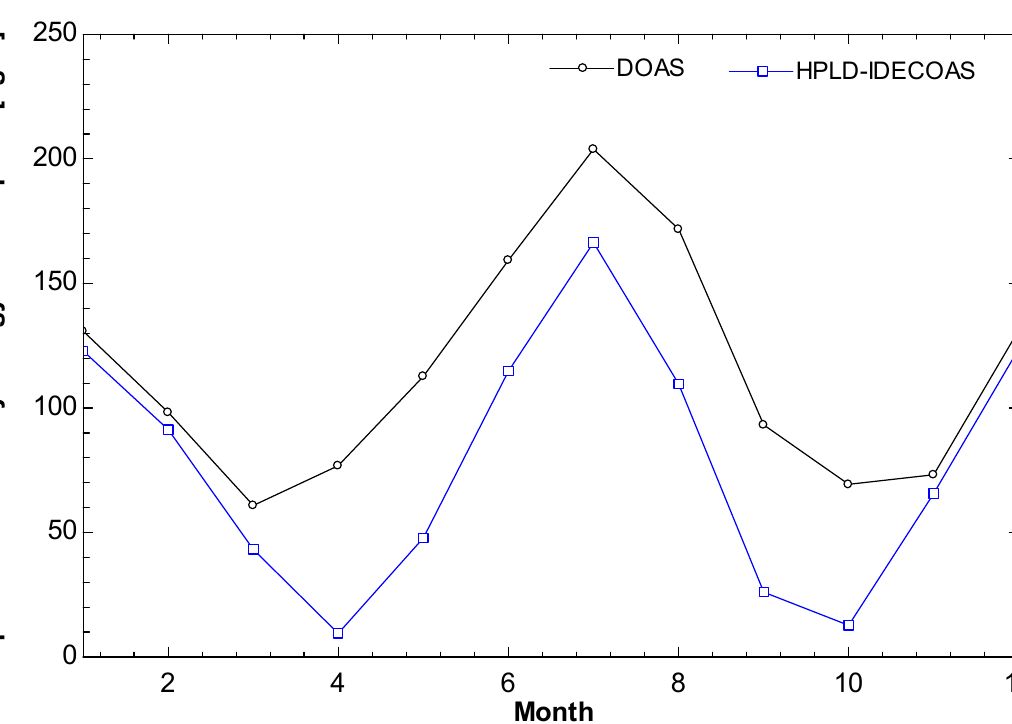
Figure 18. Comparison of monthly energy consumption in Lhasa.